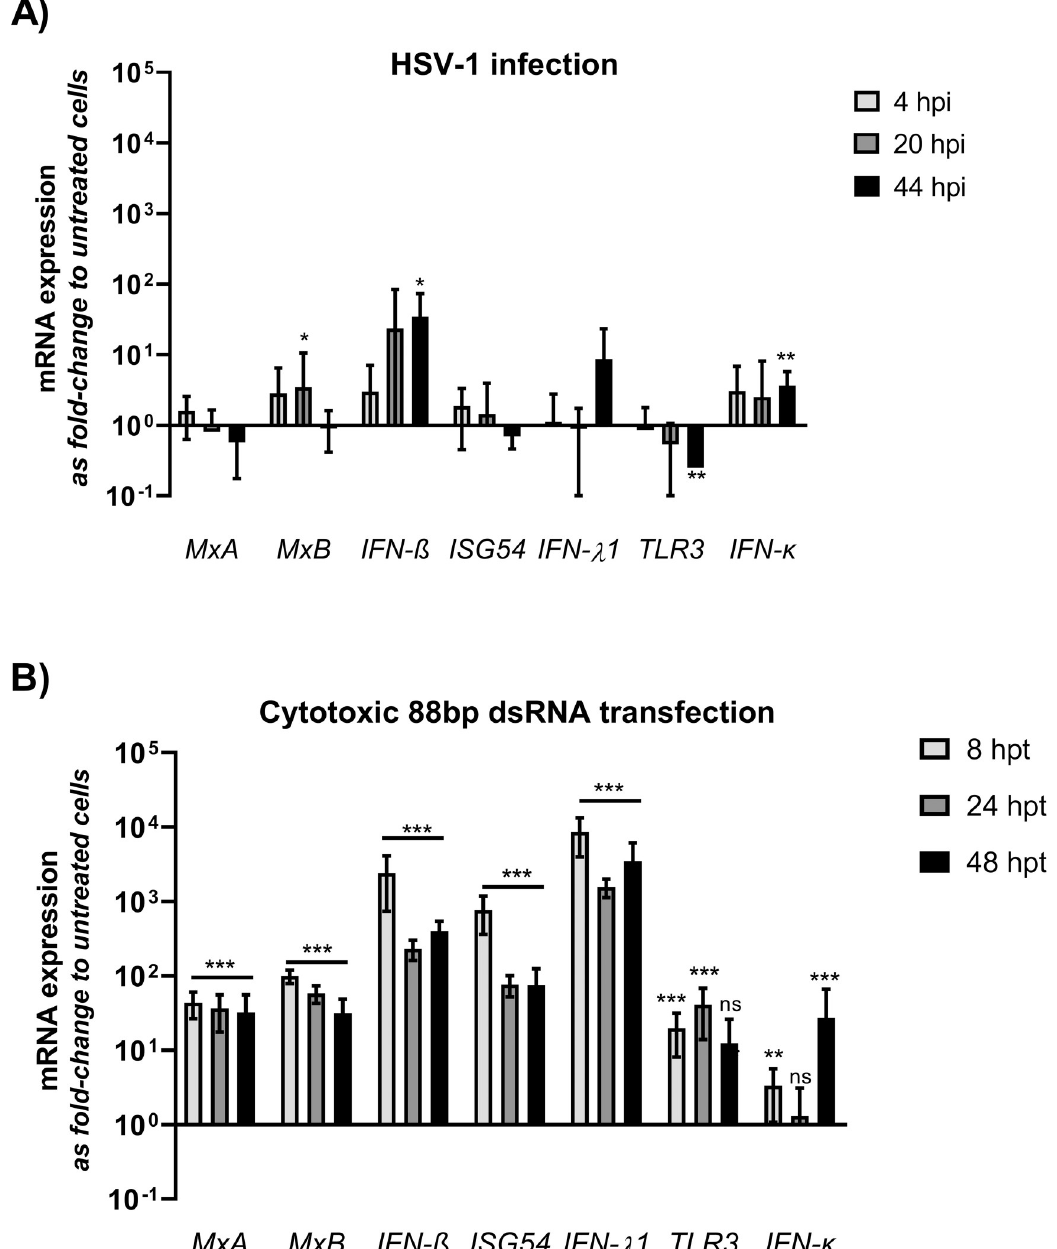
Fig 3. Relative innate immunity responses to HSV-1 infection and to cytotoxic 88bp dsRNA transfection in HCE cells. (A) HCE cells were infected with 1000 pfu of HSV-1-GFP per well on 96-well plates. At 4, 20, and 44 hours post infection (hpi) the cells were collected for RT-qPCR analysis of interferon beta ( IFN- β ), lambda 1 ( IFN- λ 1; IL-29 ), interferon stimulated gene 54 ( ISG54 ), human myxovirus resistance protein A ( MxA ), human myxovirus resistance protein B ( MxB ), toll-like receptor 3 ( TLR3 ) and interferon kappa ( IFN- κ ) mRNA expression. (B) HCE cells were transfected with 10 nM of the 88 bp dsRNA [18]. At 8, 24, and 48 hours post transfection (hpt) the cells were collected for RT-qPCR analysis of IFN- β , IFN- λ 1 (IL-29) , ISG54 , MxA , MxB , TLR3 and IFN- κ mRNA expression. The data is normalized to housekeeping gene (GAPDH) expression and shown as fold-change to the expression levels of uninfected, untreated cells. The columns indicate the mean and the whiskers the standard deviation of the analyzed variable. The data is from two separate experiments with at least four biological replicates for each treatment group in both experiments. Statistical significance is shown against untreated, uninfected cells ( � p < 0.05, �� p < 0.01, ��� p < 0.001).